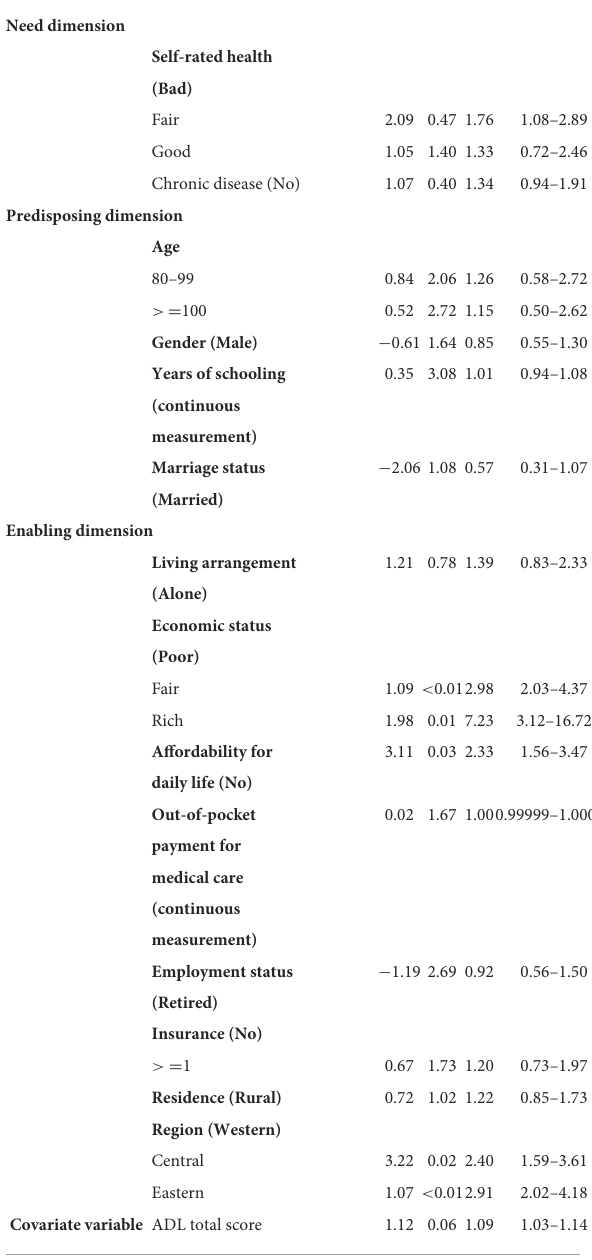
TABLE 2 Related factors of access to healthcare services among participants. Explanatory variables (reference group)